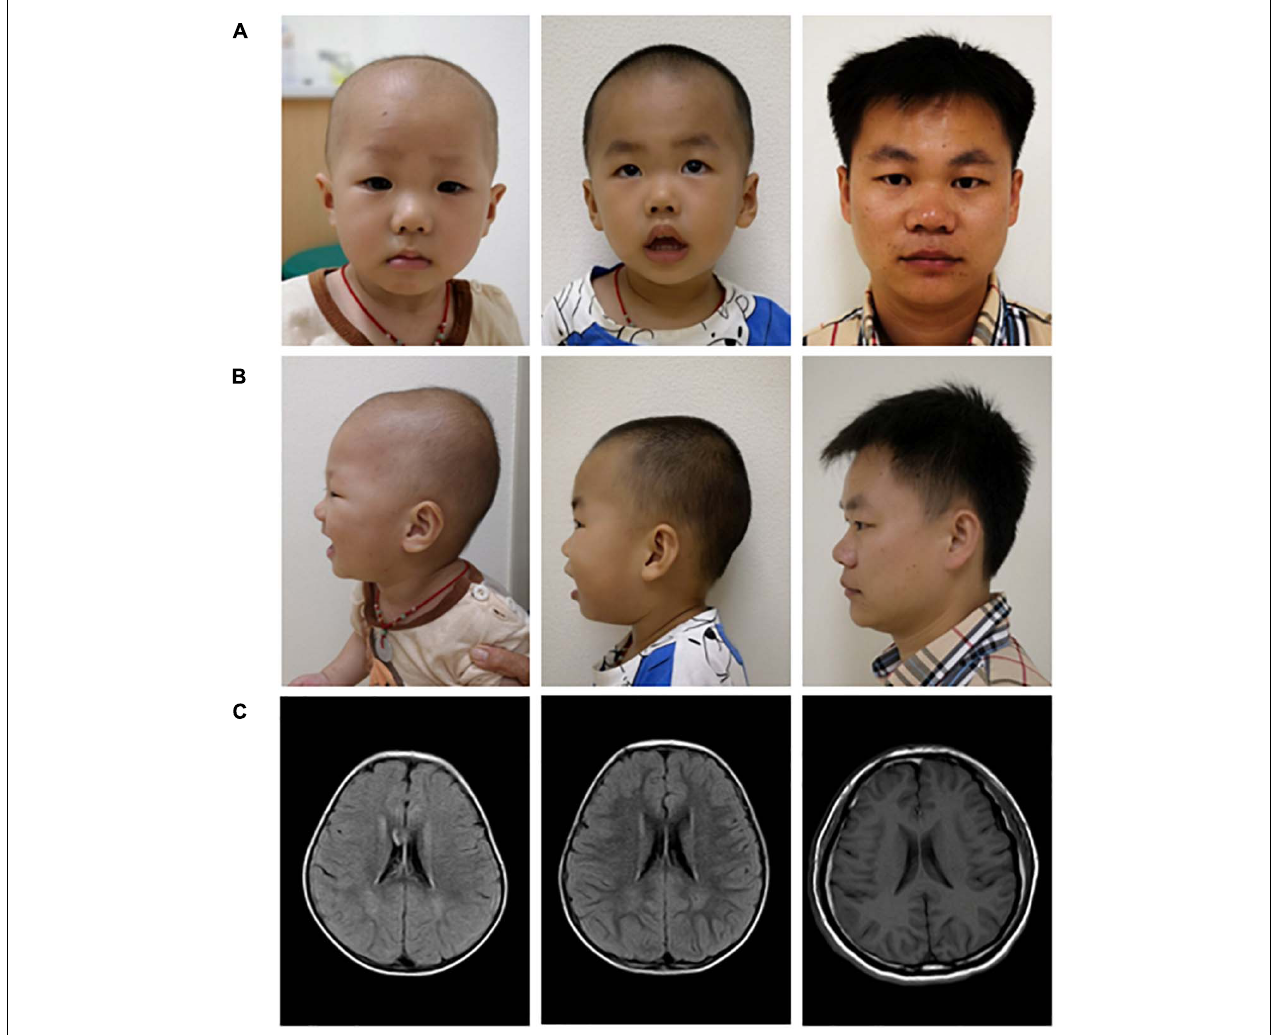
FIGURE 3 | Facial appearance (A,B) and brain MRI images (C) of three carriers with the multi-exon deletion in PACS1. Pictures of the proband (left), the elder brother of the proband (middle), and their father